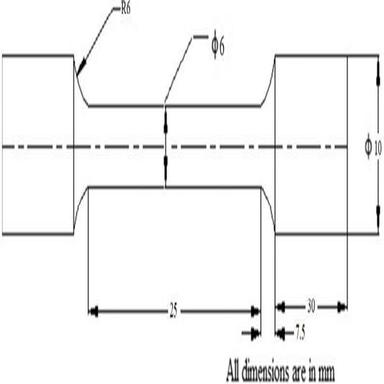
Tensile Test Specimen as per the ASTM E-08 standards